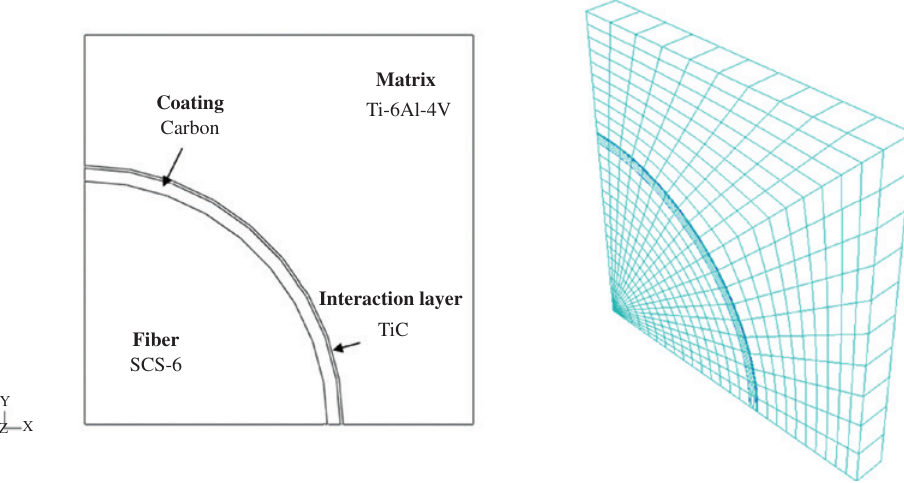
Figure 2: Schematic of the RVE with details of composite constituents and finite element